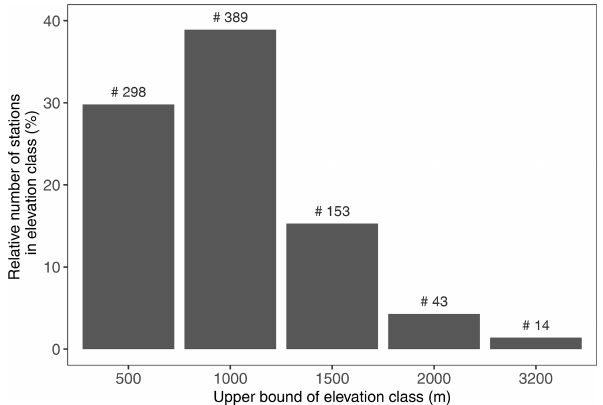
Figure 2. Relative number of stations in elevation classes, with the actual number on top of each bar (897